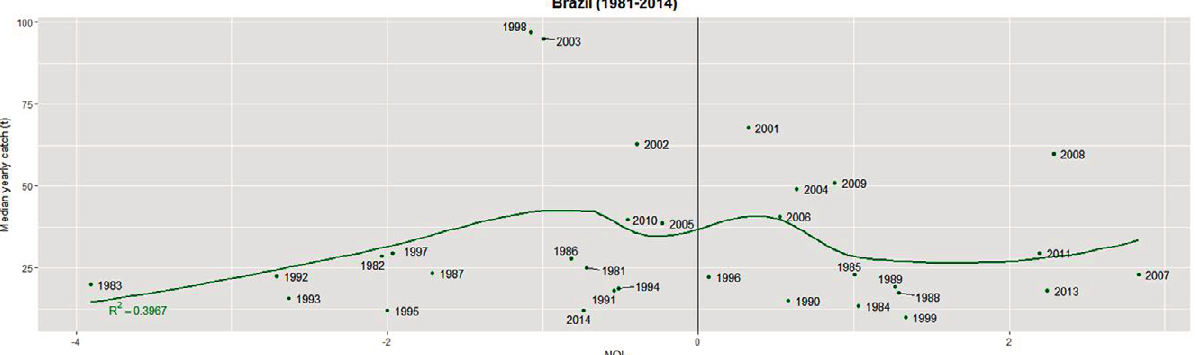
Fig. 11. – Median yearly skipjack catch in Brazil as a function of NOI signal, adjusted with a non-linear parametrized curve (rs=0.578*,